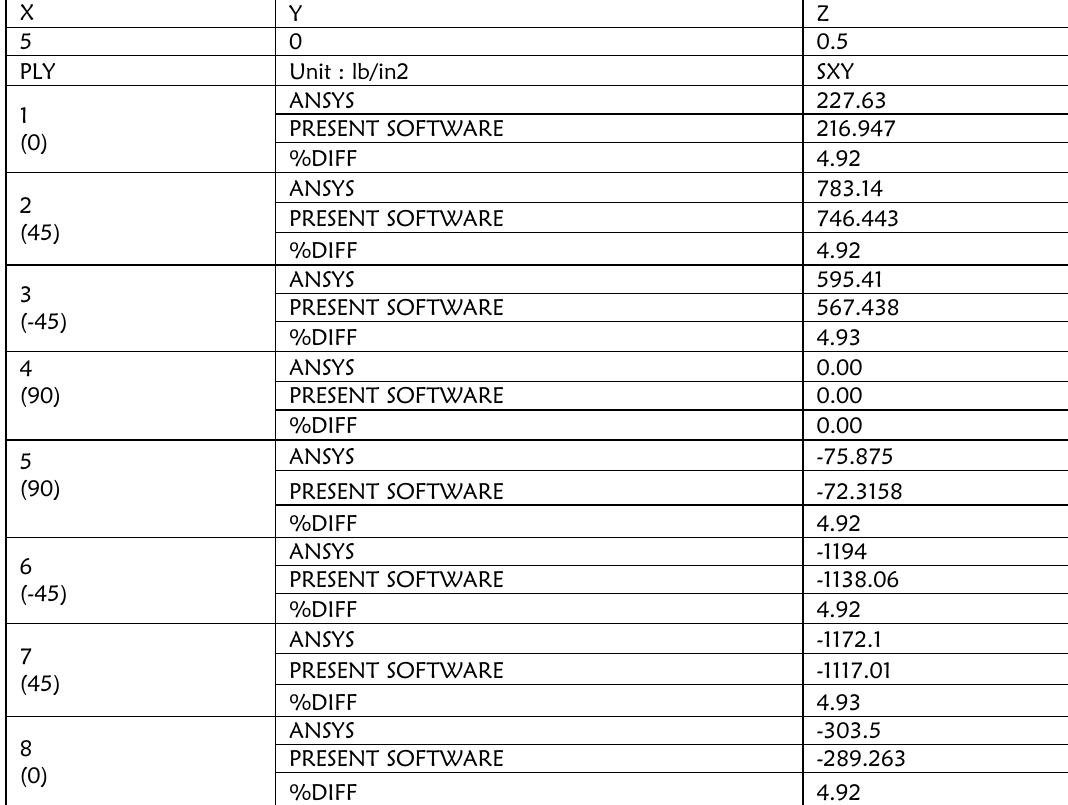
Table 3: Shear stress on the upper flange of T-beam due to torsion